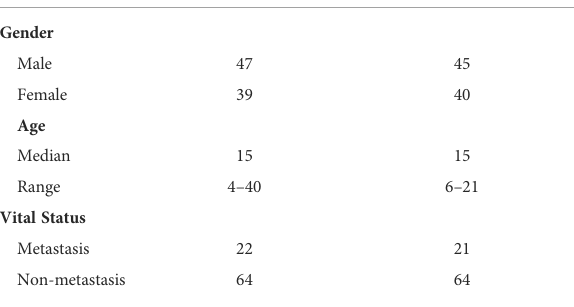
TABLE 1 Summary of patient demographics and characteristics. Characteristics Methylation Data Expression Pro fi le